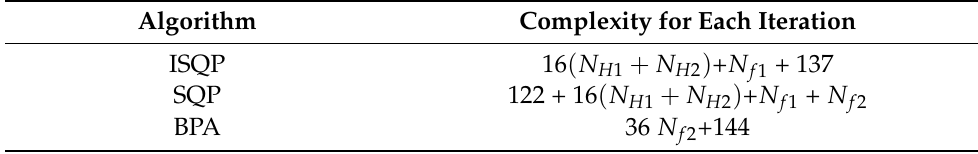
Table 2. Complexity Analysis for SISO under Perfect Channel Estimation.